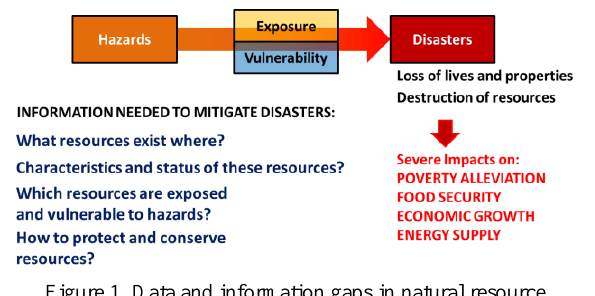
Figure 1. Data and information gaps in natural resource assessment and